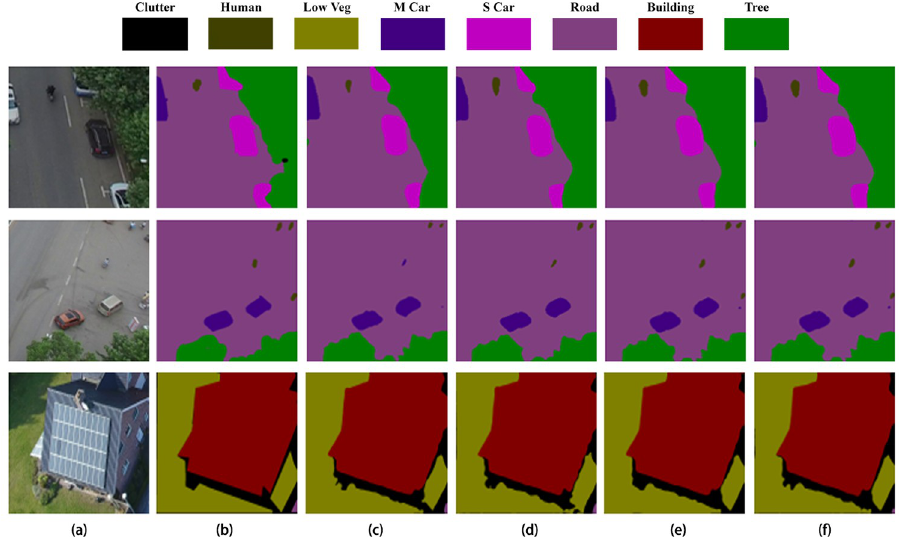
Fig 8. Comparison of segmentation results in ablation experiments. (a) The original image; (b) The label; (c) The segmentation result of Dv_Mnetv2; (d) The segmentation result of Dv_Mnetv2+EDM; (e) The segmentation result of Dv_Mnetv2+MultiL; (f) The segmentation result of EMNet. Reprinted from [16] under a CC BY license, with permission from [UAVid], original copyright [2020].